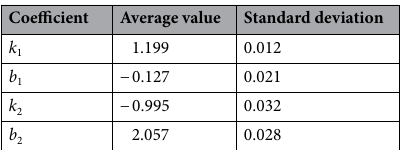
Table 5. Average values and uncertainty of the